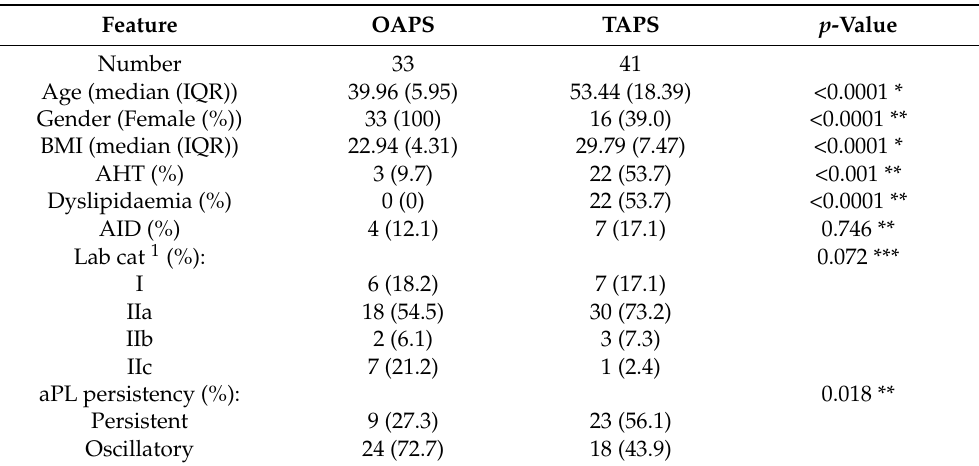
Table 1. Demographics of obstetric antiphospholipid syndrome (OAPS) and thrombotic antiphos- pholipid syndrome (TAPS)